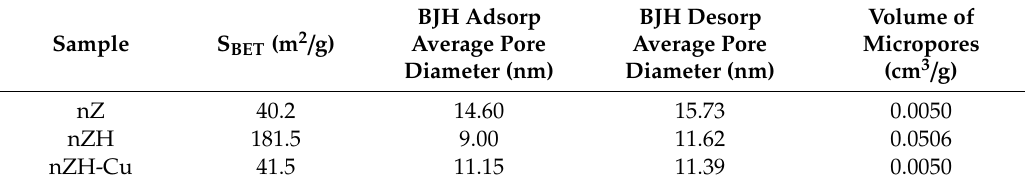
Table 1. Surface area and pore size distribution of Z, nZH, and nZH-Cu.